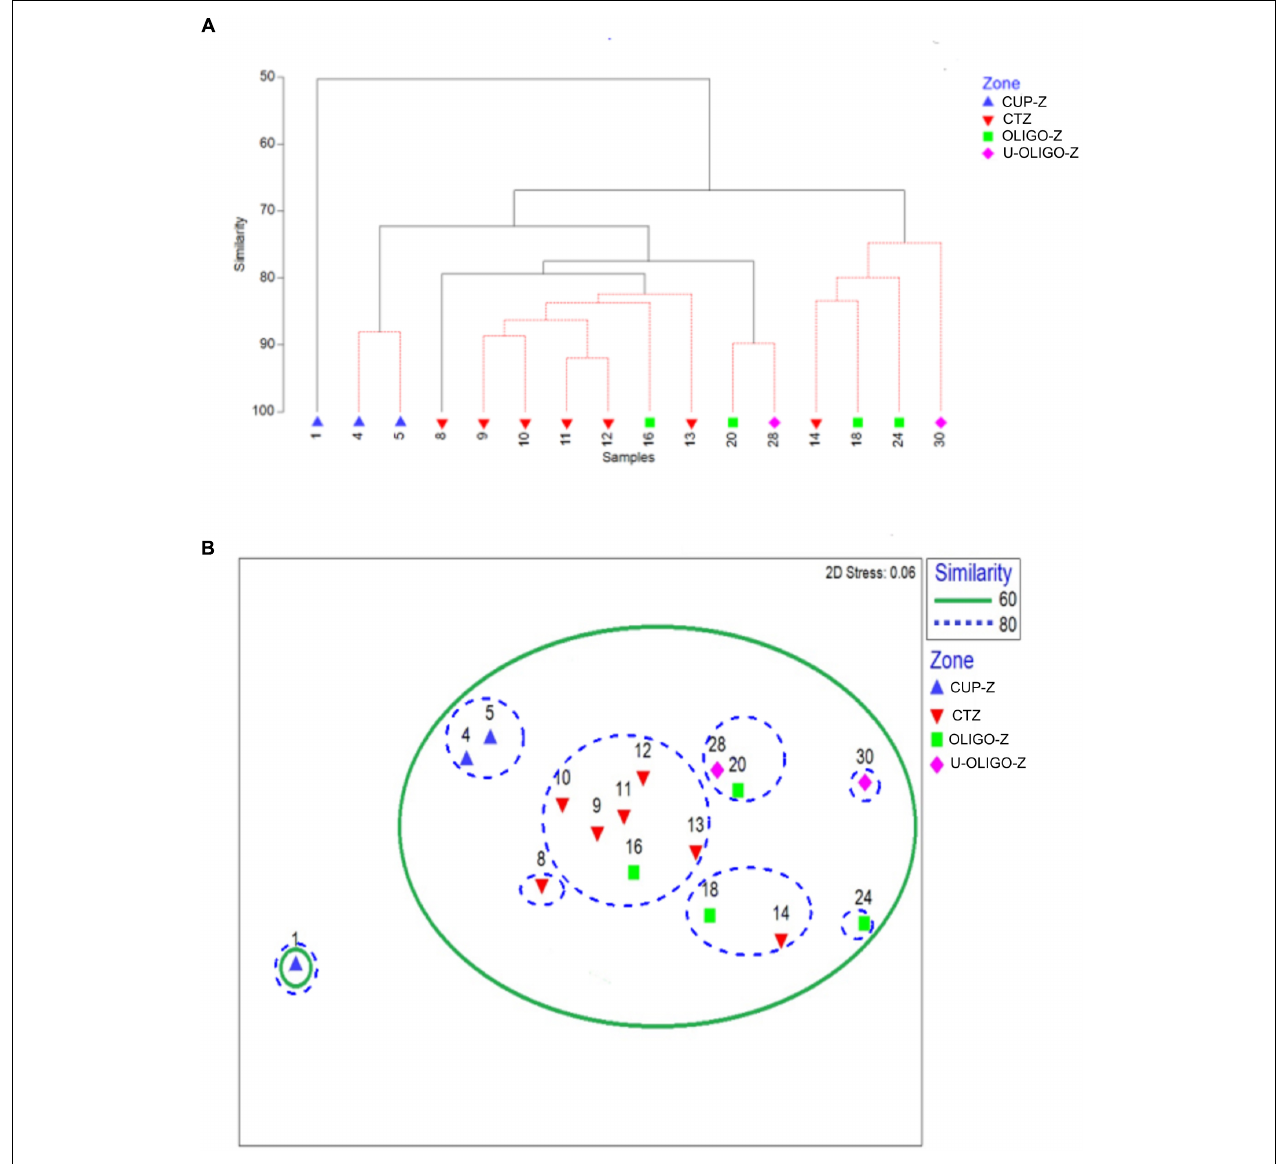
FIGURE 7 | Cluster analysis of taxonomic groups of zooplankton from the upper 0–200 m over the zonal gradient from the Chilean coast to Easter Island (A) similarity distance was Bray Curtis. Non-metric multidimensional scaling graph (NMDS) based on the Bray-Curtis distance index of 4 abundance data of the taxonomic groups (B) . Both analyses were associated with four zones across the zonal gradient: Eutrophic (CUP-Z), Mesotrophic (CTZ), Oligotrophic (OLIGO-Z) and Ultra-oligotrophic